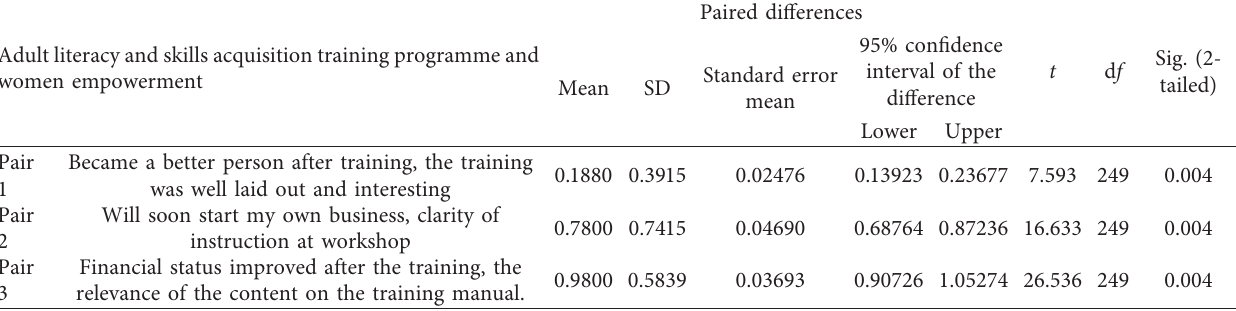
Table 2: Relationship between adult literacy and skill acquisition capacity building programmes and women empowerment using paired samples